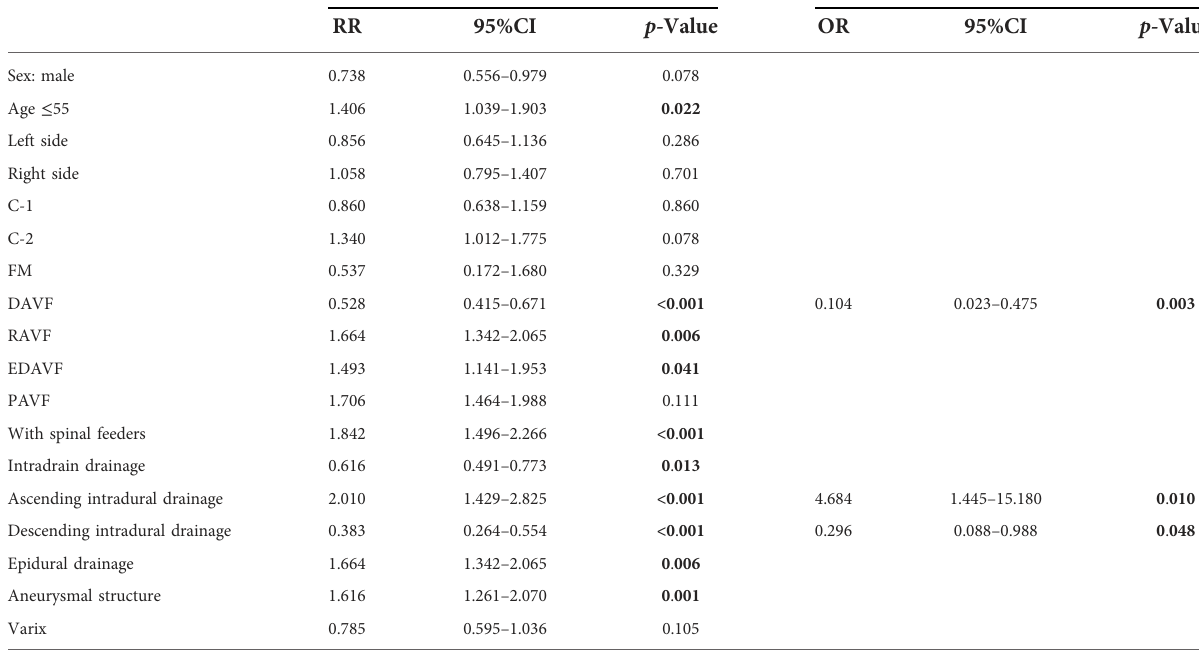
TABLE 4 Risk factors associated with